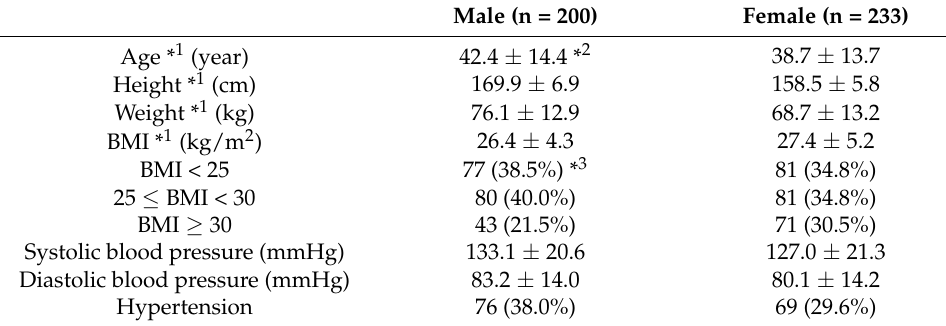
Table 1. Physical characteristics of